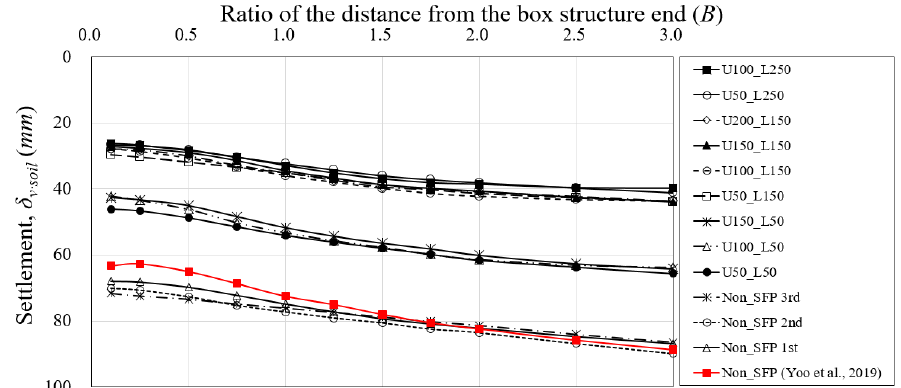
Figure 8. Test results.